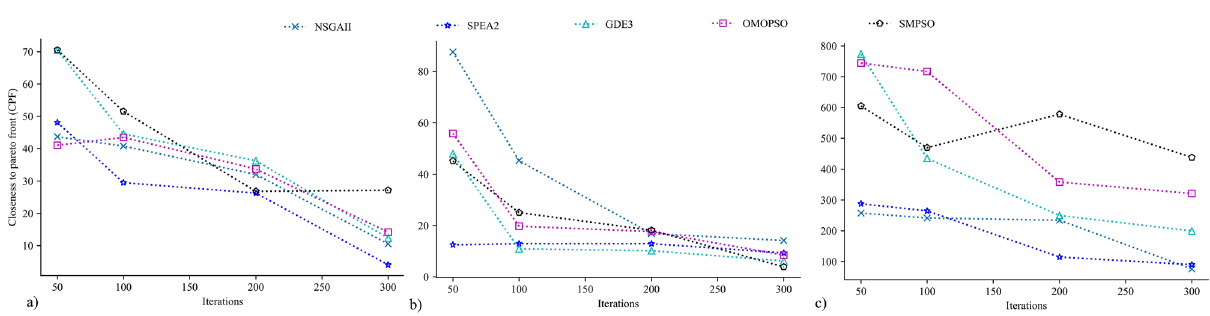
Figure 11. Distance to Pareto front of candidate fronts obtained by algorithms for ( a ) BK15, ( b ) BK40 and ( c )